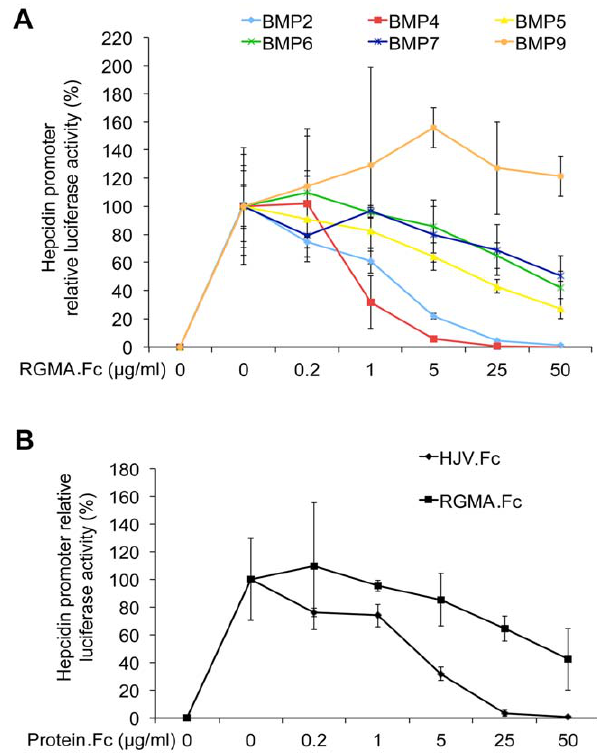
Figure 3. Soluble RGMA.Fc selectively inhibits BMP induction of hepcidin promoter luciferase activity. ( A ) Hep3B cells were transfected with the hepcidin promoter firefly luciferase construct and the control Renilla pRL-TK vector. Transfected cells were incubated alone, with 5 ng/ml BMP9, 50 ng/ml BMP5, or 25 ng/ml BMP2, BMP4, BMP6, or BMP7 ligands, or with the BMP ligands plus 0.2 to 50 m g/ml RGMA.Fc as indicated, followed by measurement of relative luciferase activity. ( B ) Hep3B cells were transfected as indicated in Panel A . Transfected cells were incubated alone, with 25 ng/ml BMP6 ligand, or with 25 ng/mL BMP6 ligand plus 0.2 to 50 m g/ml RGMA.Fc or HJV.Fc as indicated followed by measurement of relative luciferase activity. ( A–B ) Results are reported as the mean 6 SD of the percent decrease in relative luciferase activity for cells treated with BMP ligands in combination with RGMA.Fc or HJV.Fc compared with cells treated with BMP ligands alone (n=3–4 per group).